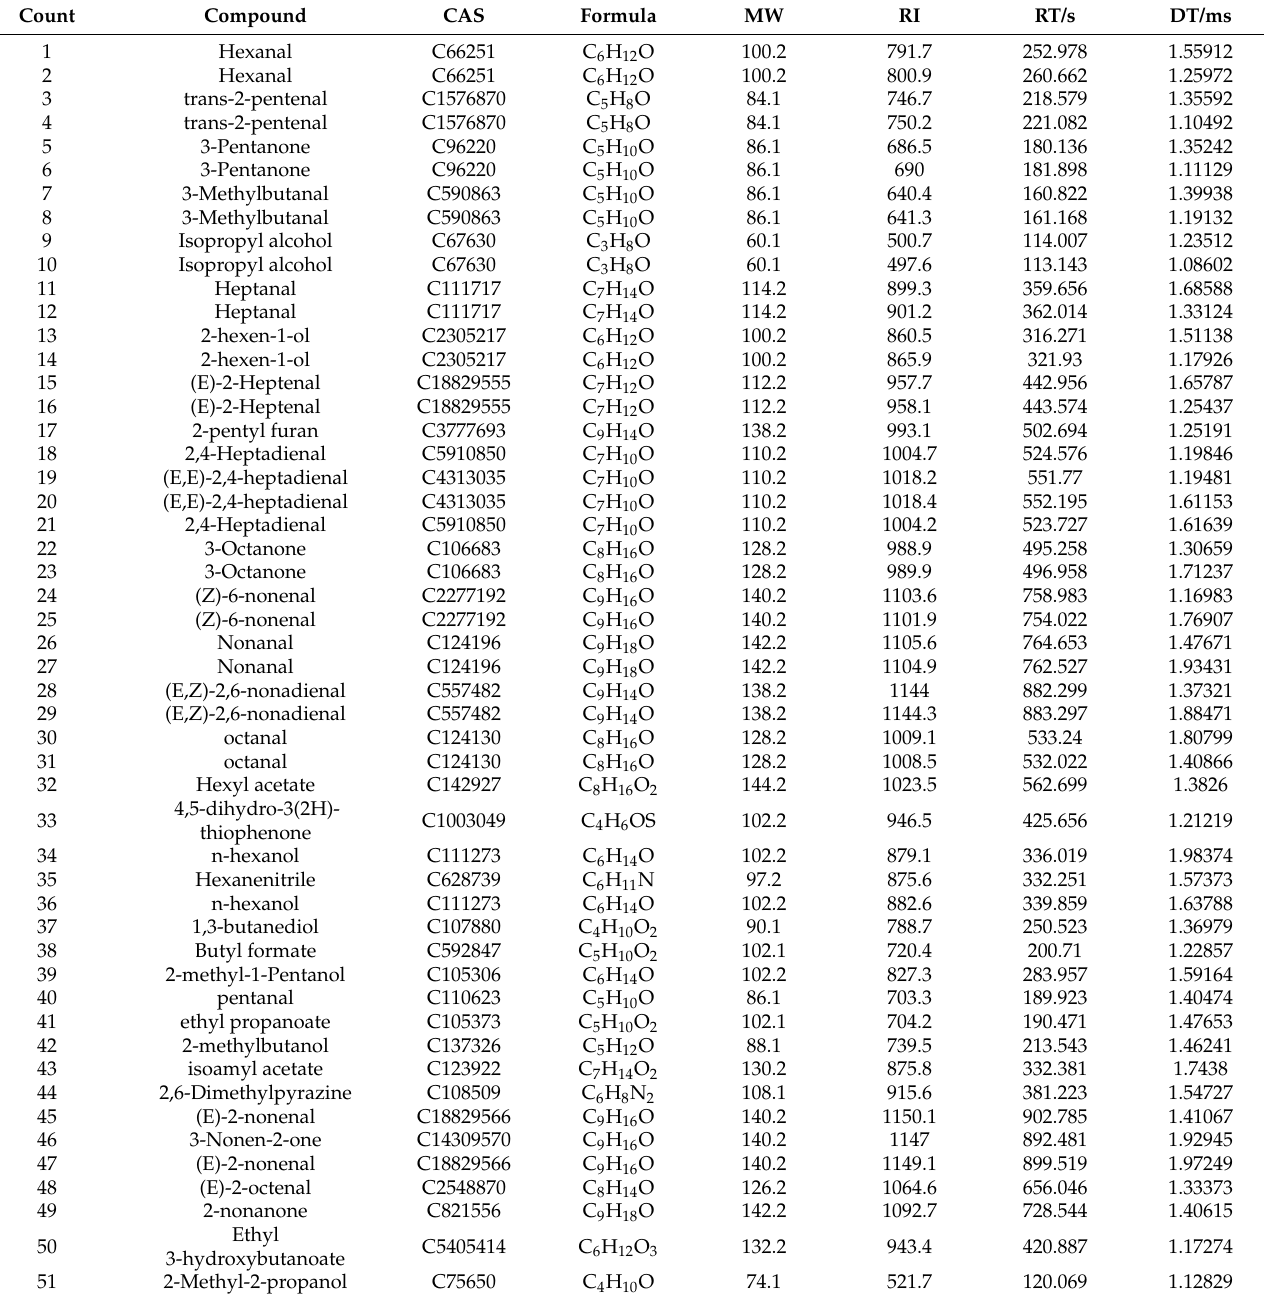
Table 3. Qualitative information of volatile organic compounds in fresh-cut cucumbers under different